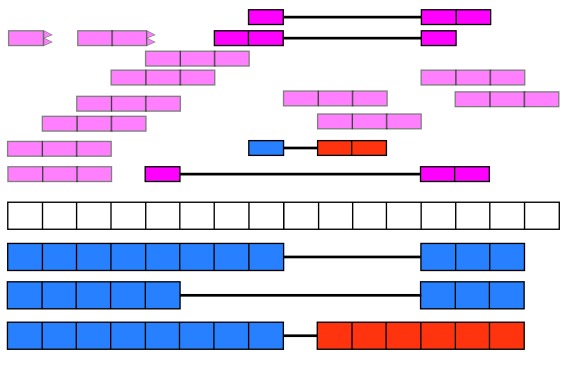
Exon-exon junctions go beyond the annotation.Reads spanning exon-exon junctions are highlighted and compared against the annotation. Three of them match the annotated junctions, but one (blue and orange read) spans an unannotated exon-exon junction with the left end matching the annotation and the right end hinting at a possible new isoform for this gene (blue and orange isoform).